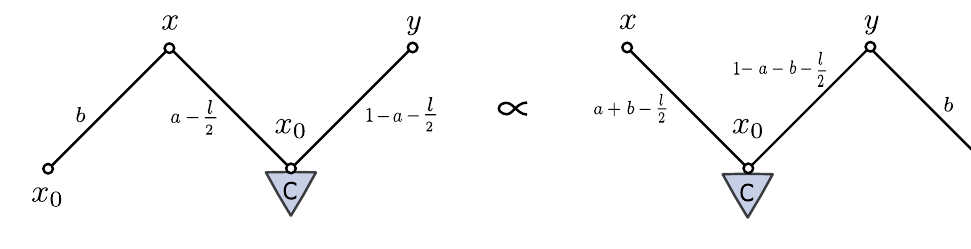
Figure 18 . Graphical representation of the identity